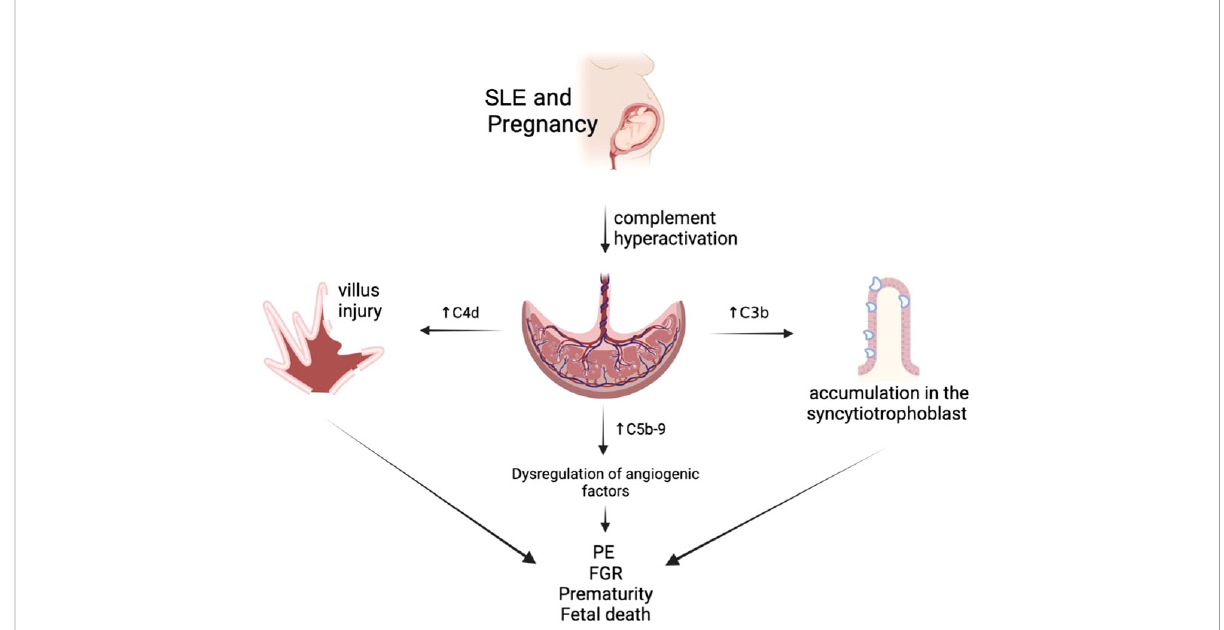
FIGURE 2 Complement alterations of patients with systemic lupus erythematosus